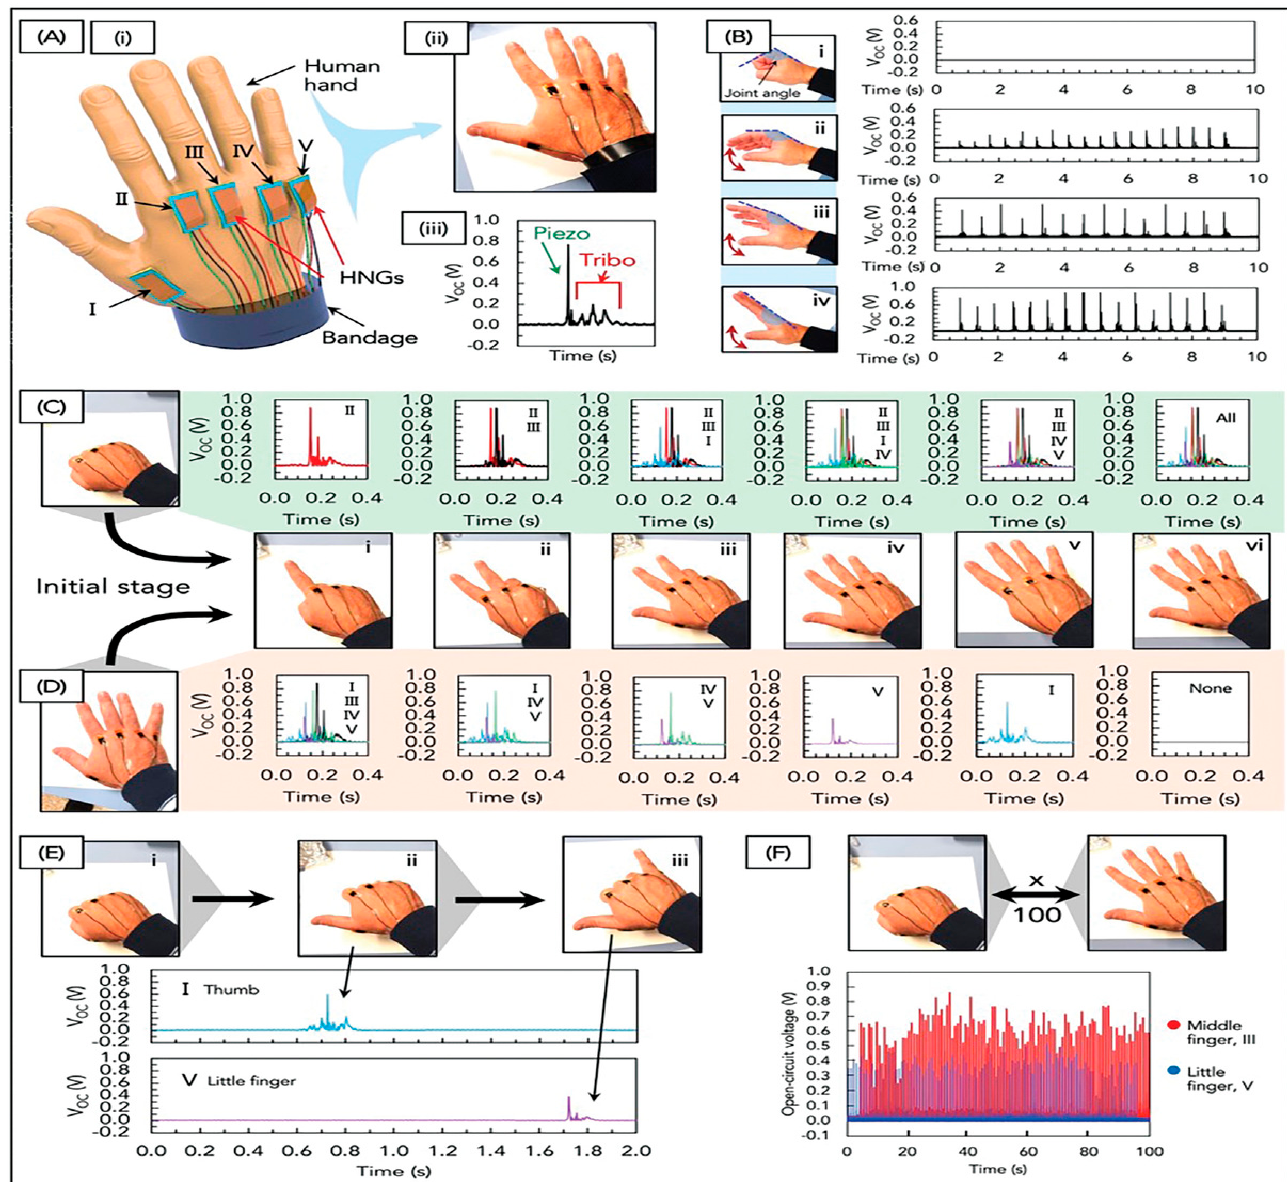
Figure 19. The detection of hand motions using the developed WHSs. ( A ) Five sensors are attached to the back of a human hand in positioning scheme (i) and picture (ii). A detected signal corresponding to the hyperextension of the index finger (iii). ( B ) The signal provided by WHS applied to the middle finger for different hand apertures. ( C , D ) The detected signals generated by five WHSs at the hand’s rear, starting from the closed ( C ) or the open ( D ) hand, for various conditions: distended index finger (i), index and middle finger (ii); thumb, index, and middle finger (iii); all fingers except for the pinkie (iv); all fingers (v). ( E ) A series of actions involving the thumb and pinkie that begin with the closed hand. ( F ) The reliability measurement obtained during 100 repetitions of the closed-opened